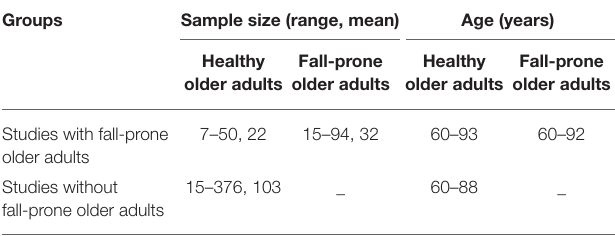
TABLE 3 | Sample size and age range of the two groups.